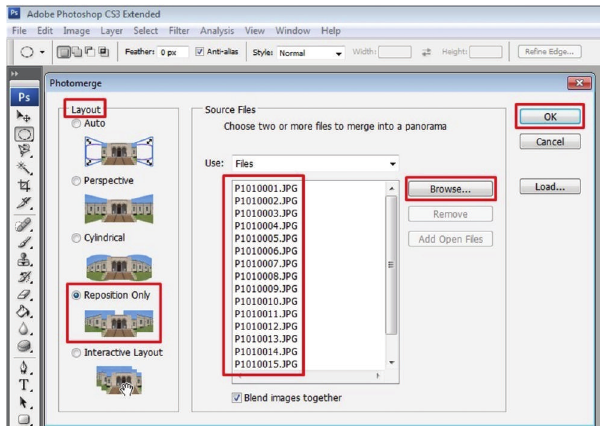
Figure 8: Go to file > automate > photo merge to actually merge. Browse files from folder where the optimized files are stored and select all and hit OK. Note the red boxes in the figure. Follow them for an easy workflow.